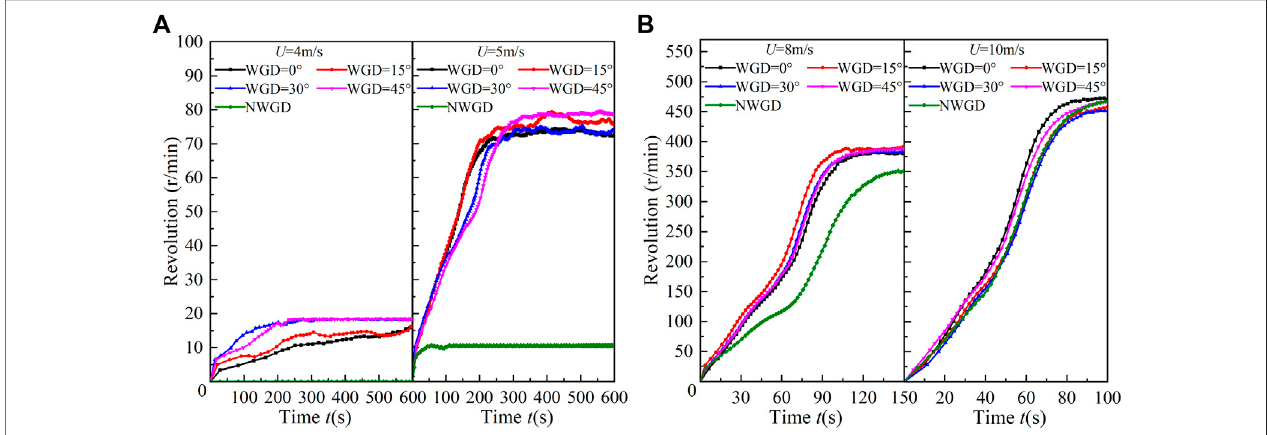
FIGURE 13 | Rotational revolutions of the rotor with and without the WGD by wind tunnel tests.